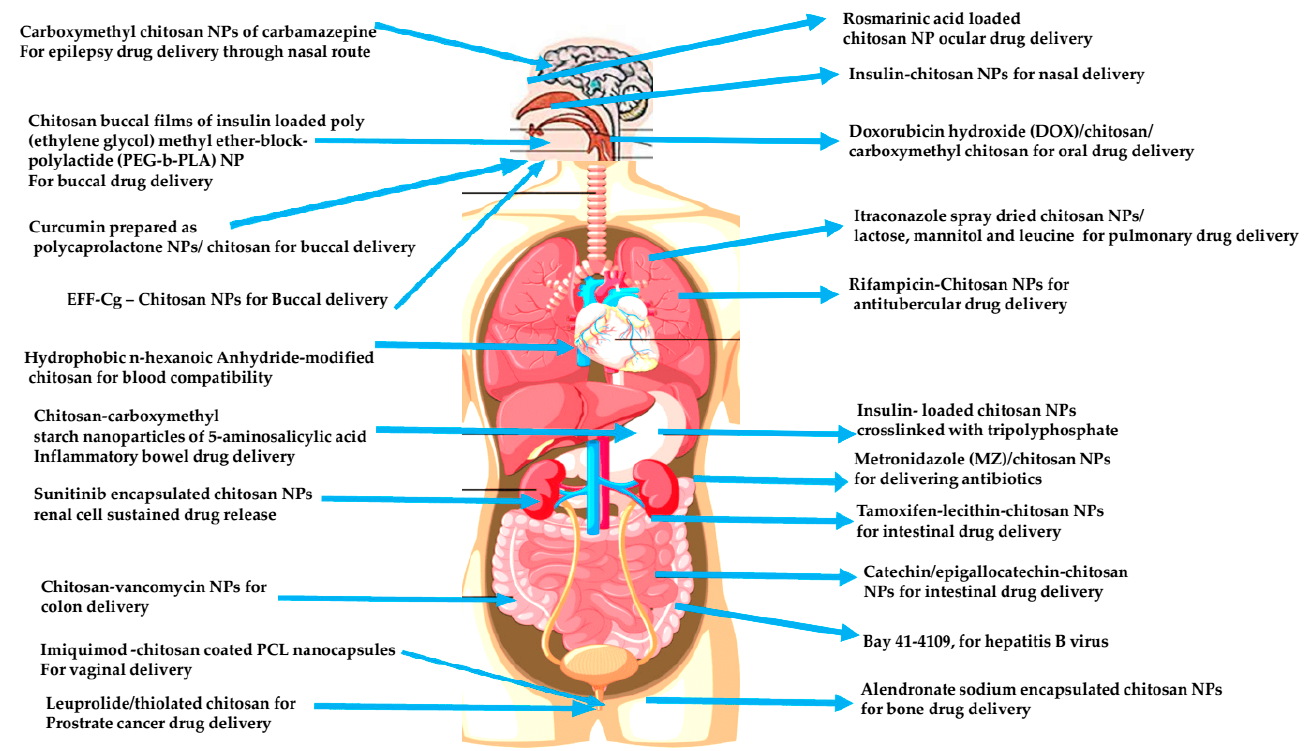
Figure 2. Overview of various drug delivery applications demonstrated by chitosan and its nanoforms.